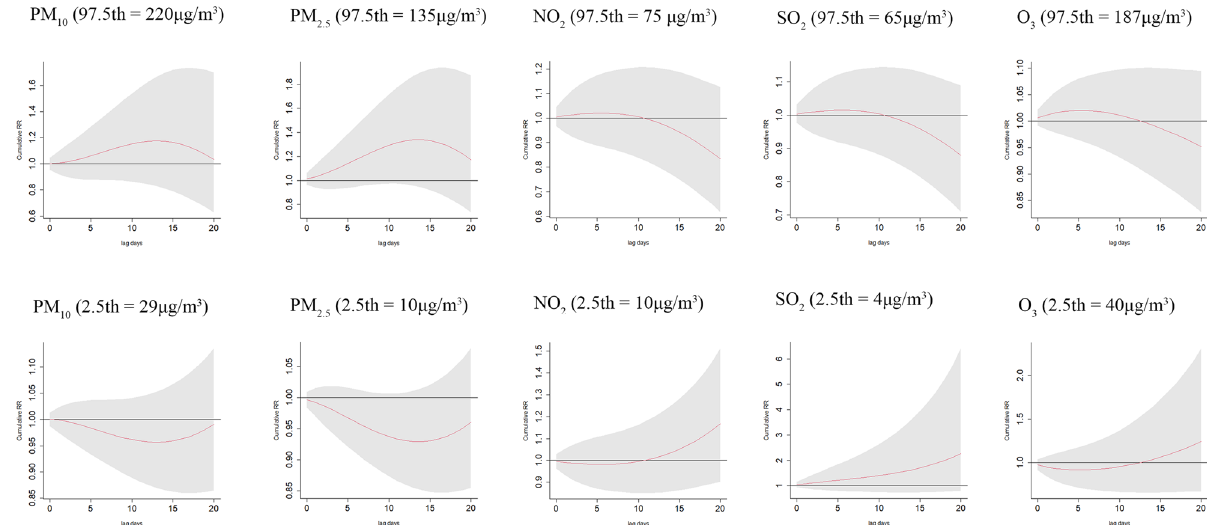
Figure 3. The cumulative effects of extreme PM 10 , PM 2.5 , NO 2 , SO 2 , O 3 on the incidence of